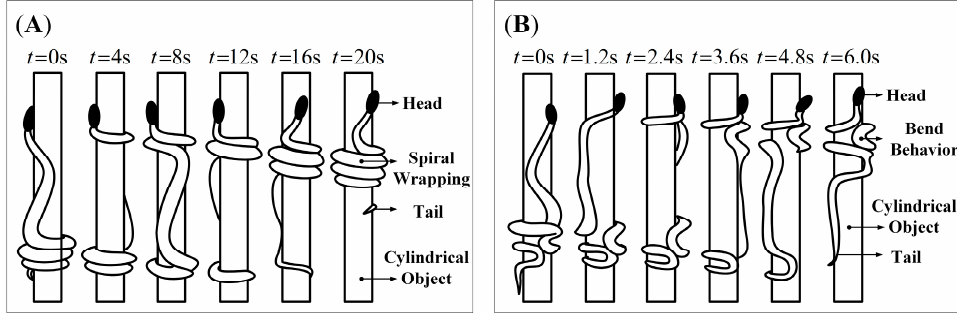
Figure 1. Different types of spiral climbing movement by a snake: ( A ) “Folds and Stretches”—wrapping helically and moving forward; and ( B ) “Spirals and Laterals”—Gripping during lateral undulation.